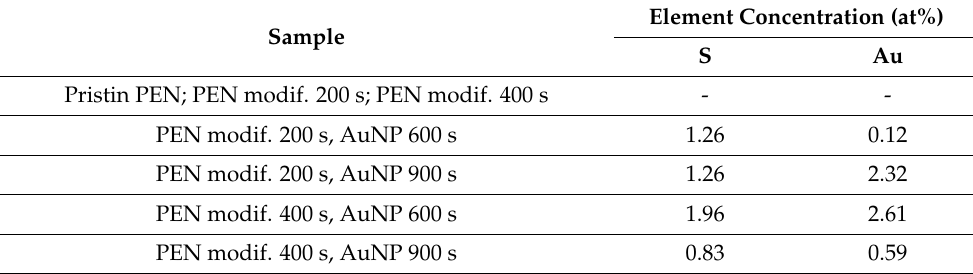
Table 1. Atomic concentrations of elements (S, Au) determined using the XPS method in pristine PEN, PEN modified with plasma 8 W for 200 and 400 s, and PEN modified with plasma 200 and 400 s after 24 h of immersion in AuNP/NALC/H 2 O solution (NALC/H 2 O ratio—1.5 g/100 mL), deposition time 600 and 900 s.